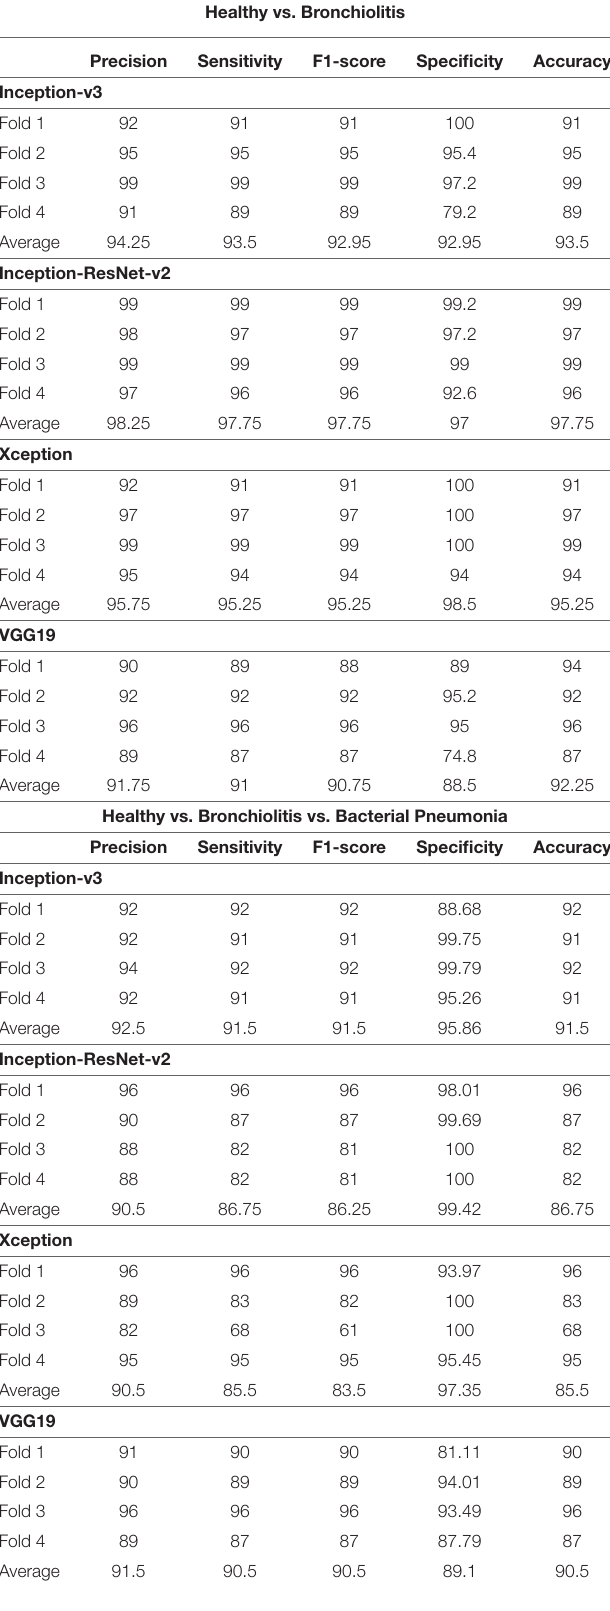
TABLE 1 | Classification